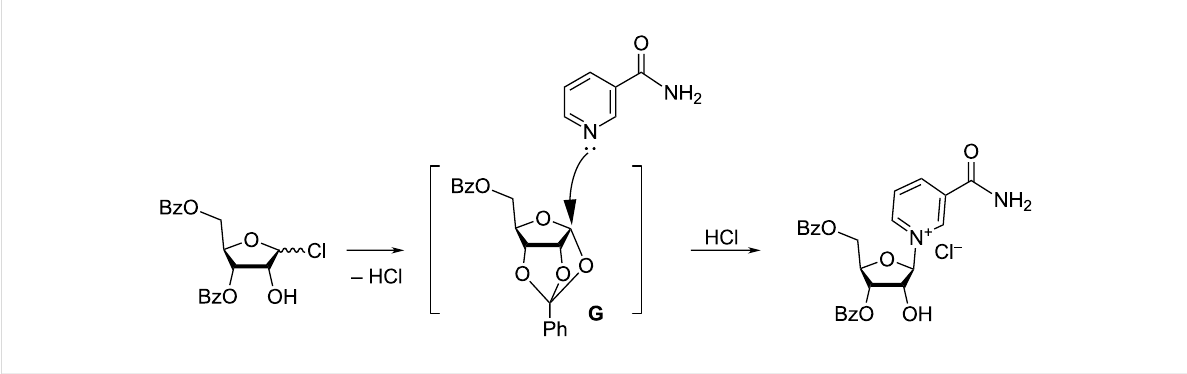
Figure 4: Mechanism of the formation of the β -anomer of the glycosylated product in the case of the reaction of 3,5-di- O -benzoyl- α / β -D-ribofuranosyl chloride with Nam.